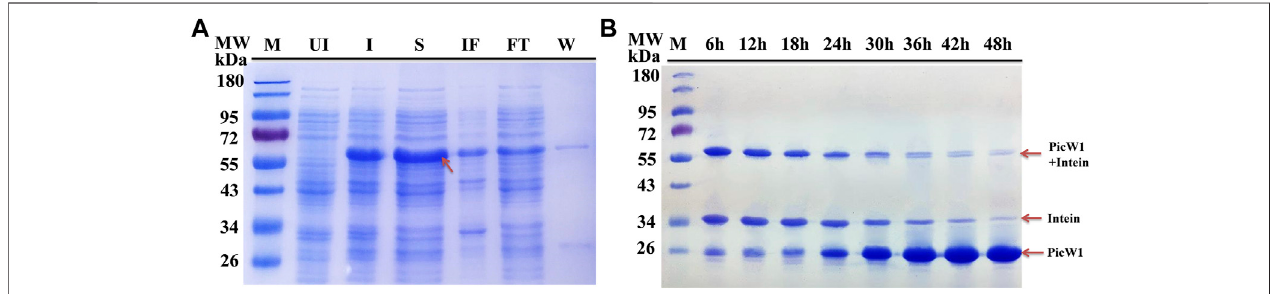
FIGURE 2 | Puri fi cation of recombinant PicW1 by chitin-af fi nity chromatography. (A) SDS-PAGE analysis of the puri fi cation of PicW1-intein expressed in E. coli BL21 (DE3) cells. Lane 1, Marker = M; Lane 2, Un-induced BL21 cells lysate = UI; Lane 3, IPTG-induced BL21 cells lysate = I; Lane 4, Cell supernatant = S; Lane 5, Insoluble fraction = IF; Lane 6, Flow through = FT; Lane 7, wash with buffer B =W. Protein extraction along with intein tag at a range of about 55 kDa. (B) SDS-PAGE of PicW1 puri fi cation process using the chitin column. Lane1, marker; Lane 2 to Lane 9: 6, 12, 18, 24, 30, 36, 42, and 48 h represents the puri fi cation